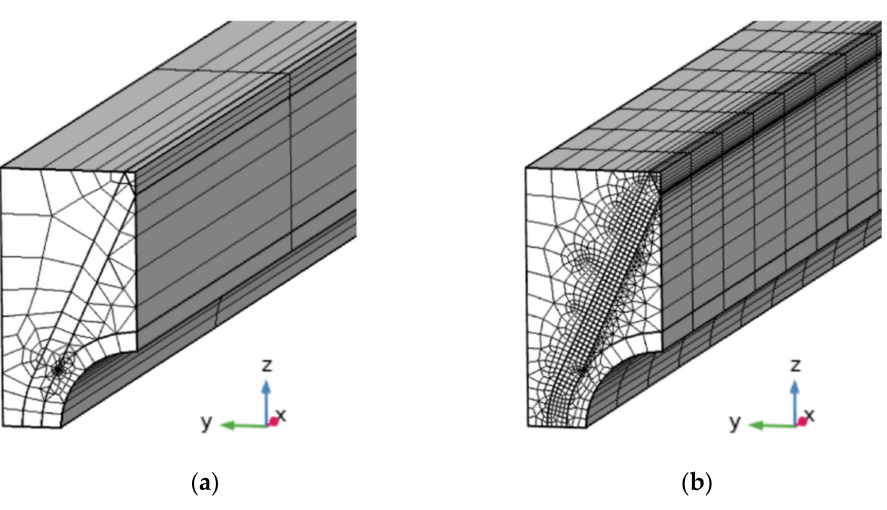
Figure 11. Coarsest ( a ) and finest ( b ) mesh configuration for the PCM and heat exchanger structure. The mass flow per heat exchanger with 47 tubes was set to the maximum applied mass flow for the measurement (see Section 3.1) of 88.5 kg/h and a temperature step at the inlet ∆ T step of 20